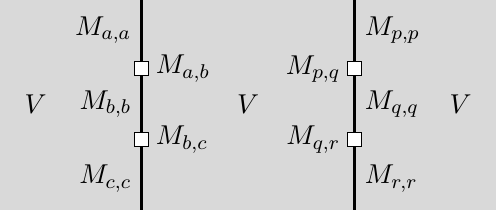
Figure 1 . Macroscopic observables on the worldsheet of a 1+1D